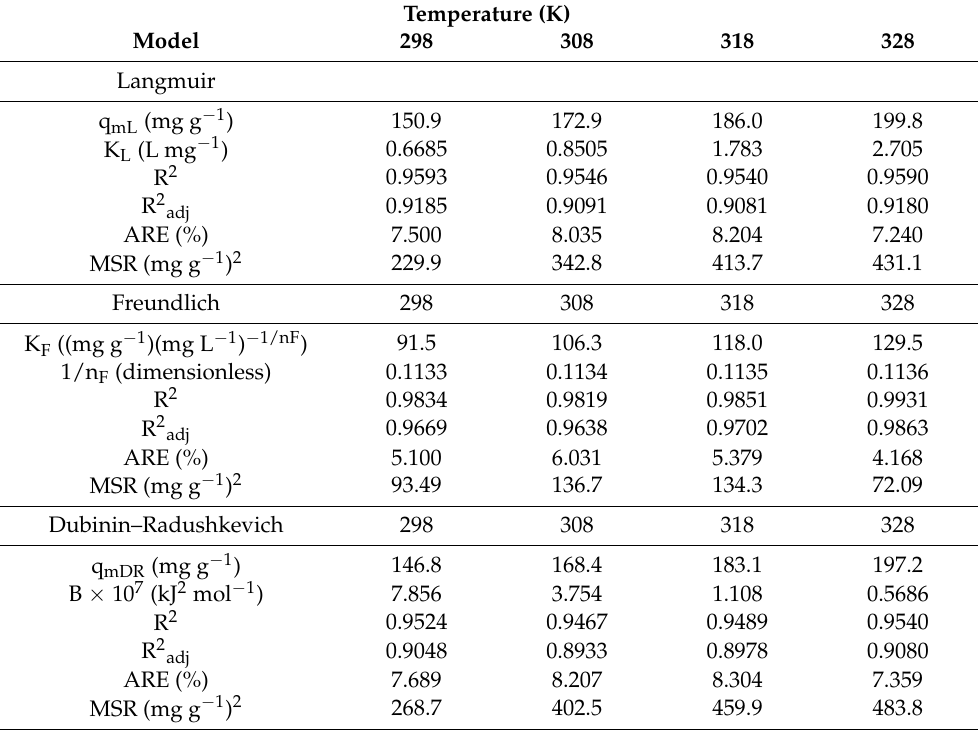
Table 1. The isothermal parameters for Diuron adsorption on CPAC.